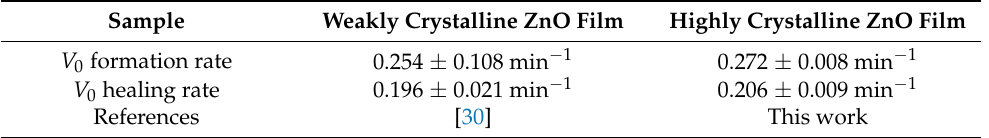
Table 1. V 0 formation and healing rates calculated from changes of the Raman band enhancement ( G PIERS − P ) over time for two zinc oxide films with a different crystallinity (weakly crystalline film = all the XRD peaks are weakly intense (see reference [30]); highly crystalline film = some XRD peaks are very intense (see Figure